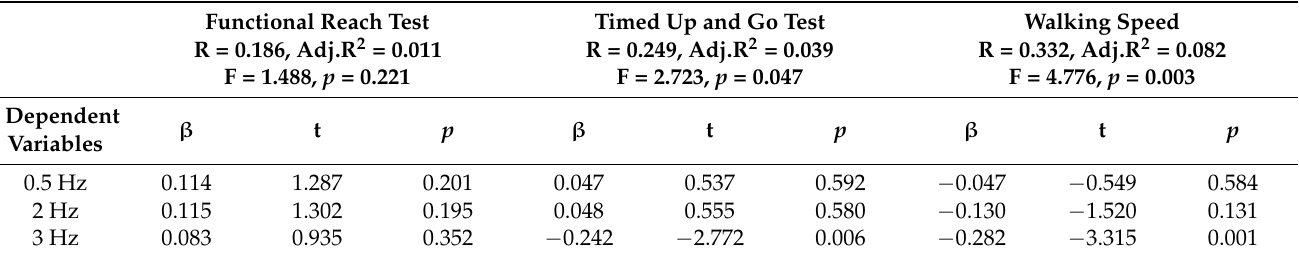
Table 2. Comparisons of variables between faller and